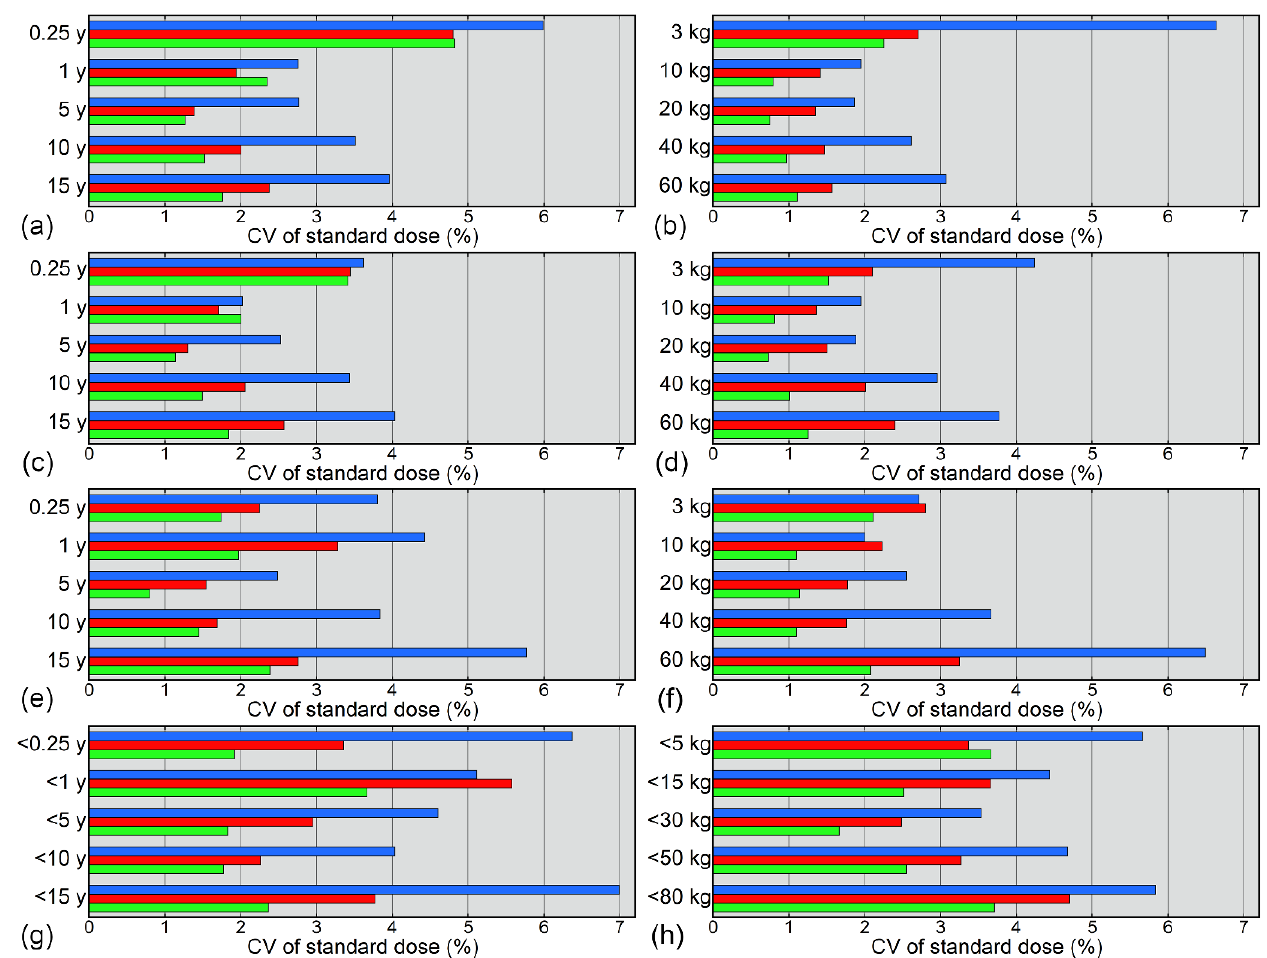
Figure 5. CVs of standard doses estimated based on age ( a , c , e , g ) or weight ( b , d , f , h ). Standard doses were estimated using logarithmic fitting ( a , b ), power fitting ( c , d ), bilinear fitting ( e , f ), and grouping ( g , h ). The blue, red, and green bars represent values for small, medium, and large datasets, respectively.